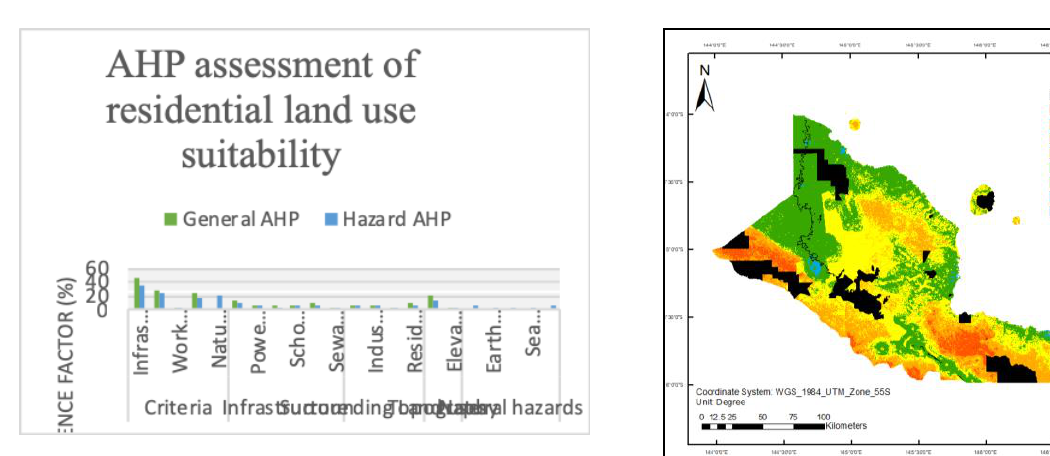
Figure 3. AHP weights of residential land-use suitability